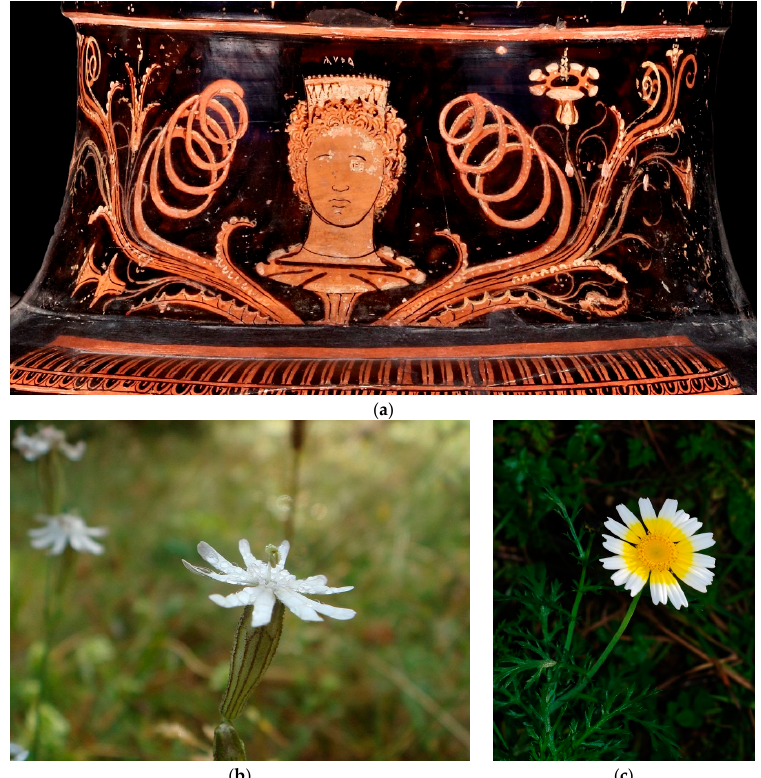
Figure 23. ( a ) London, British Museum F 277 Apulian volute-krater, Iliupersis Painter, ca. 370–350 B.C. Head of Aura (labeled) emerging from flower flanked by tendrils. Note the flower in the upper right with white-tipped petals. Photograph © The Trustees of the British Museum. ( b ) Silene italica . Photograph courtesy of Wikimedia Commons. ( c ) Chrysanthemum coronarium . Photograph courtesy of Wikimedia Commons.